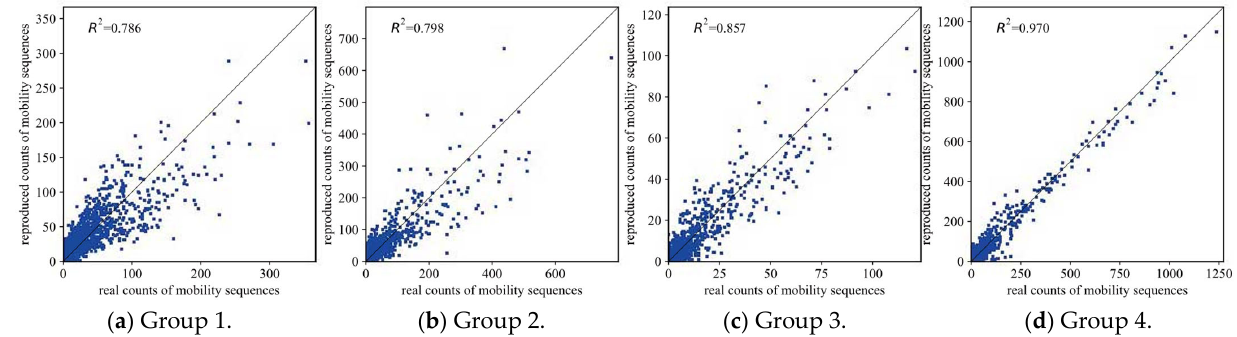
Figure A6. Spatiotemporal evaluation for each group for 1978. ( a ) Evaluation for Group 1; ( b ) Eval ‐ uation for Group 2; ( c ) Evaluation for Group 3; ( d ) Evaluation for Group 4.